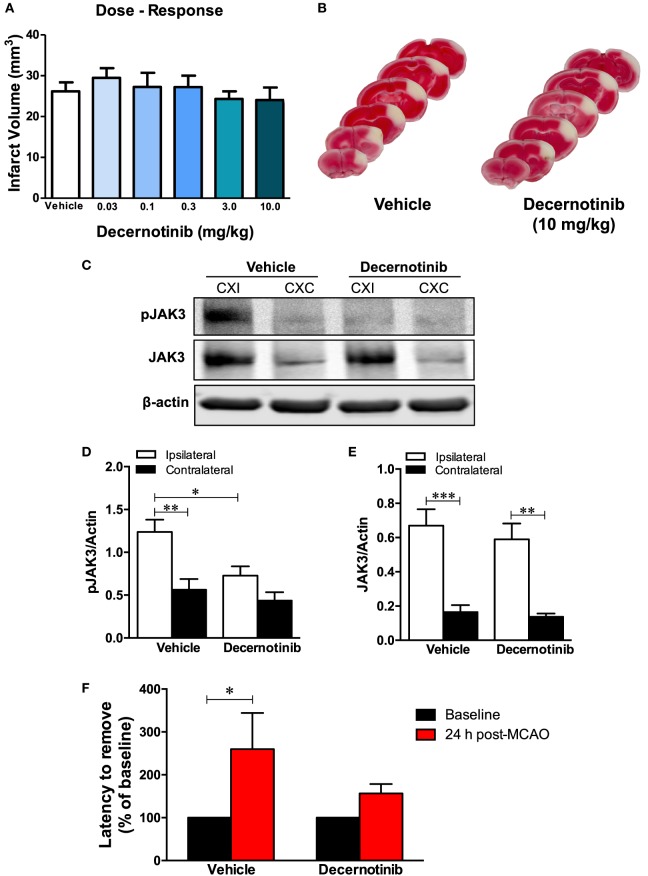
(A) Dose–response curves measuring infarct volume in vehicle-treated and 0.03, 0.1, 0.3, 3, and 10 mg/kg of decernotinib-treated mice. There was no significant difference in infarct size across groups (vehicle, n = 8; 0.03 mg/kg, n = 6; 0.1 mg/kg, n = 8; 0.3 mg/kg, n = 8; 3 mg/kg, n = 10; and 10 mg/kg, n = 8). Data were analyzed using a one-way ANOVA with a Dunnett’s multiple comparison post-test. (B) Representative 2,3,5-triphenyl-tetrazolium chloride (TTC) images of vehicle- and 10 mg/kg decernotinib-treated mice to show extent of cortical injury in our model of permanent middle cerebral artery occlusion (MCAO). (C) Representative immunoblots of brain tissue obtained from the ipsilateral (CXI) and contralateral (CXC) cerebral cortex depicting reduced phosphorylation of Janus kinase 3 (JAK3) in the 10 mg/kg decernotinib group compared to vehicle. There is no effect of decernotinib on stroke-induced increase in total JAK3 levels. (D,E) Graphical summary of immunoblot data (*P < 0.05 compared to vehicle ipsilateral; vehicle, n = 9; 10 mg/kg decernotinib, n = 5). Data were analyzed using a two-way ANOVA. (F) Latency to remove the sticky tape from the contralateral paw, measuring sensorimotor deficits, in vehicle and decernotinib groups. Stroke induced a significant increase in the latency to remove the sticker at 24 h in the vehicle-treated group. Comparing both treatments at 24 h, there was a trend toward a better performance in the adhesive removal test in mice given decernotinib, but this effect did not reach a statistical significance (two-way ANOVA with Bonferroni post-test; vehicle n = 9; decernotinib at a dose of 10 mg/kg, n = 10).